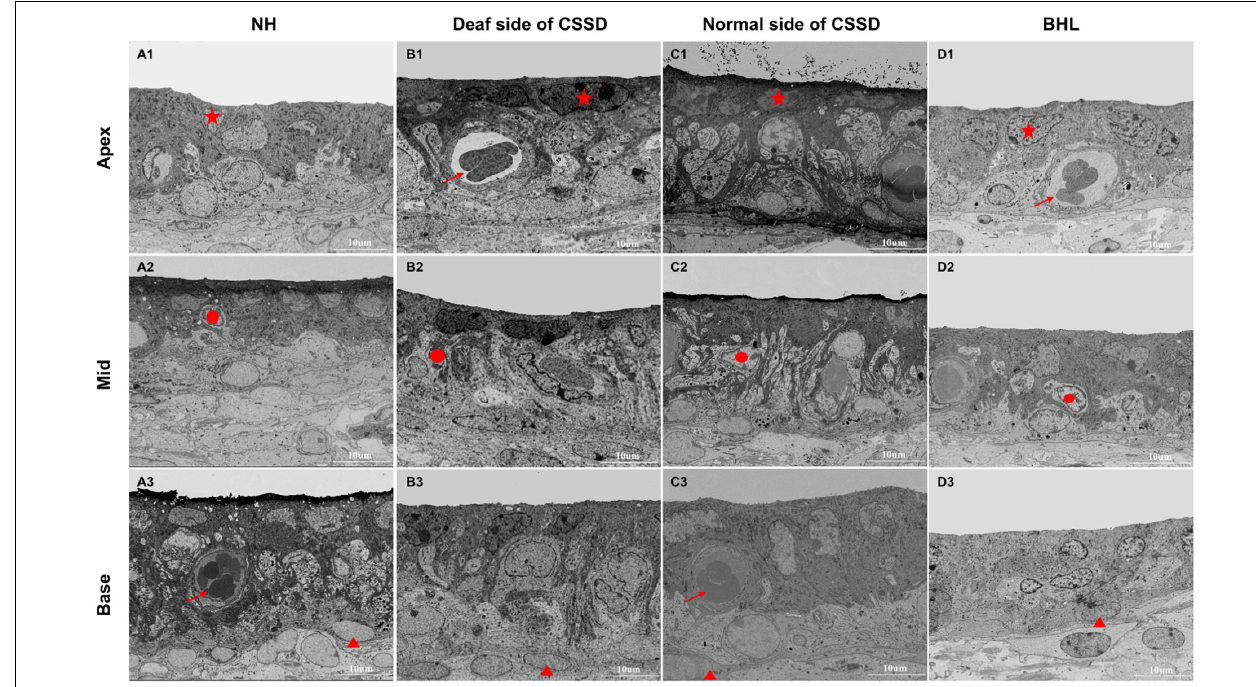
FIGURE 9 | The SEM images of stria vascularis of different phenotypes in the congenital single-sided deafness (CSSD) pedigree at P30. (A1-D3) SEM images of the stria vascularis at different turns of normal hearing (NH), deaf side (DS) of CSSD, normal side (NS) of CSSD, and bilateral hearing loss (BHL). For NH, three layers of cell could be clearly identified: star, marginal cell; circle, intermediate cell; and triangle, basal cell. Vascularis (arrow) could be seen in some parts of the stria vascularis. No obvious malformation was observed in the DS of CSSD and NS of CSSD; in the BHL, the three layers of cells were disorganized, and the stria vascularis was thinner than